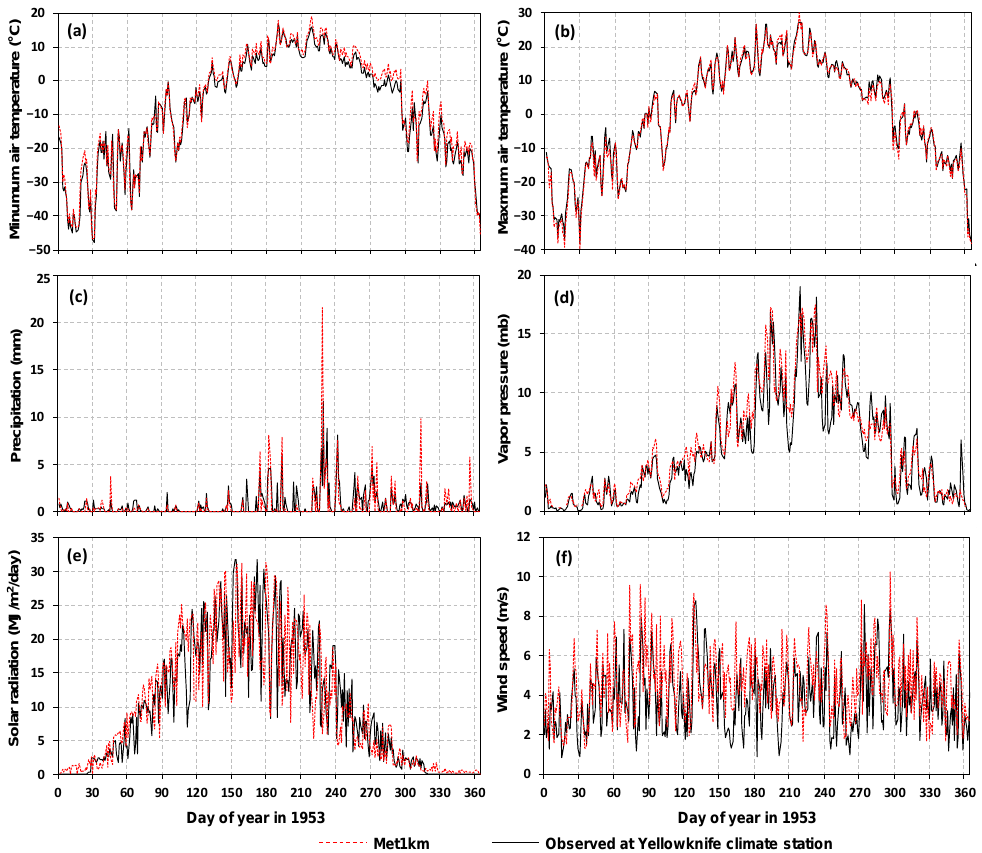
Figure 5. Comparisons between Met1km dataset and observations at the Yellowknife airport climate station in 1953 for difference climate variable. ( a ) Daily minimum air temperature; ( b ) daily maximum air temperature; ( c ) precipitation; ( d ) vapor pressure; ( e ) solar radiation; and ( f ) wind speed.